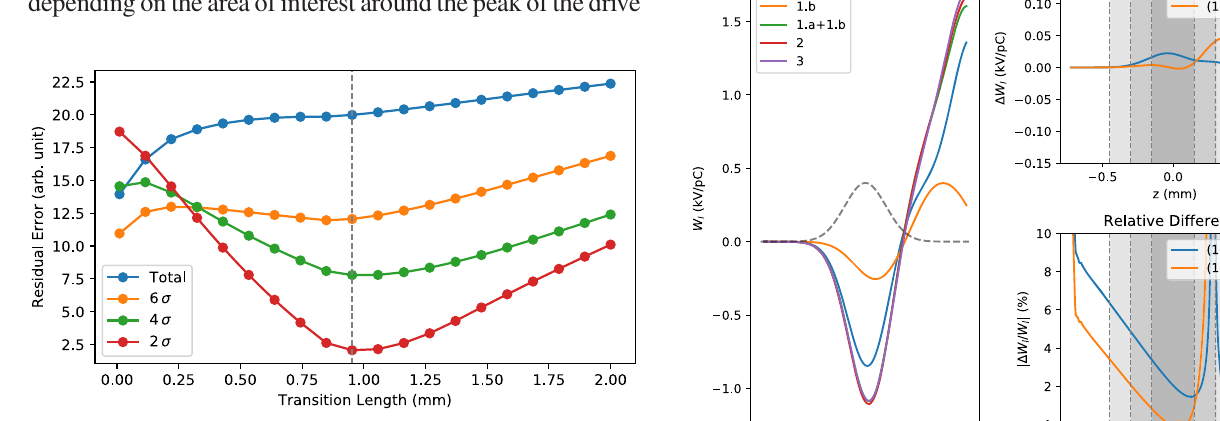
FIG. 12. Integrated residual difference between the wakefield obtained from the sum of two singular DLW segments and a combined device with a linearly tapered transition region of length l t , as shown in Fig. 11. The different curves correspond to the 6 σ , 4 σ and 2 σ parts of the drive bunch, as well as the complete simulation box (total). The data is normalized to the respective ROI size for comparability.